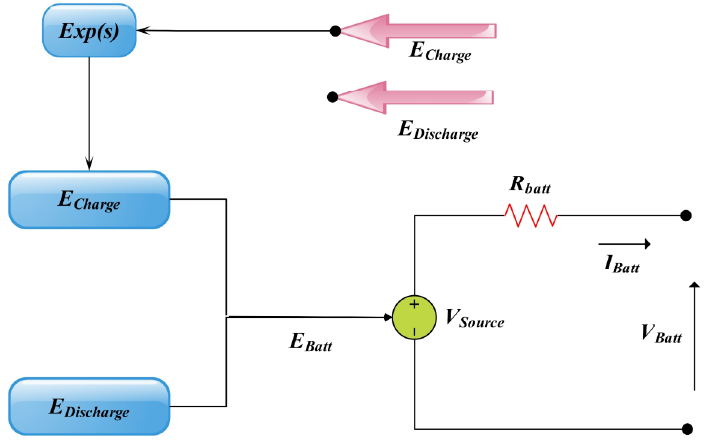
Figure 8. Lithium-ion battery simulator